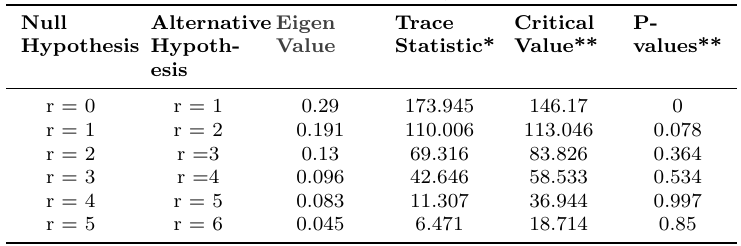
Table 3: The Cointegration Test